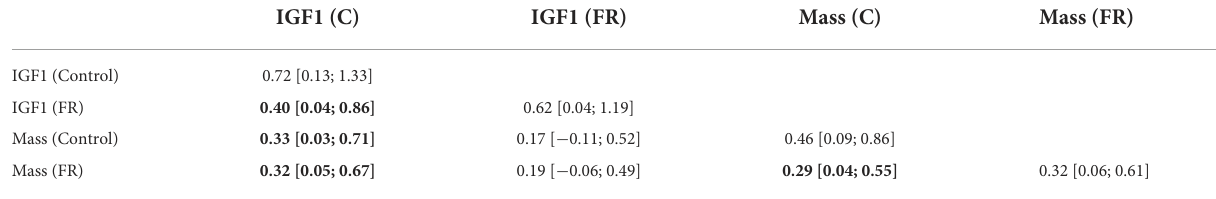
Table 2 Variance-covariance matrix from the multivariate MCMCglmm model including IGF-1 and body mass under each treatment (control, “C” or food restricted,